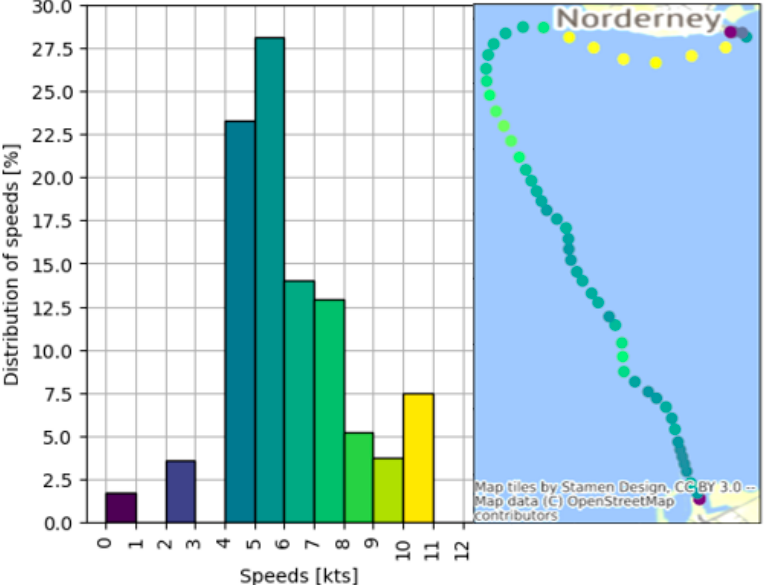
Figure 4. Speed profile and AIS tracking of one crossing by the Frisia III from Norddeich to Norderney. Note that more direct crossings are not possible due to the shallow waters of the Wadden Sea (Source: By author).